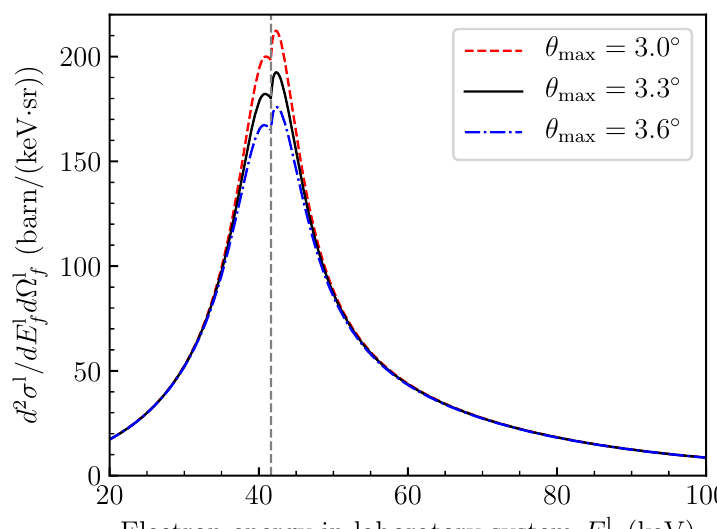
0 ◦ in the 75.91 MeV/u U 89 + -N 2 collision. Presented are the f ≈